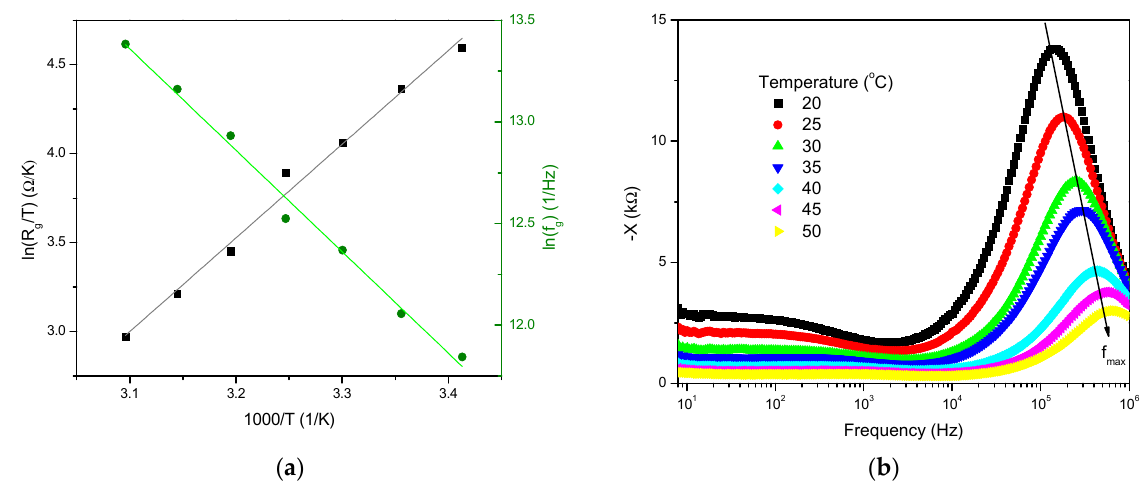
Figure 9. Temperature dependence of grain resistance ( R g ) and grain relaxation frequency ( f g ) ( a ) and frequency dependence of imaginary part of impedance ( b ) of NiMn 2 O 4 -alginate nano-biocomposite thick film.